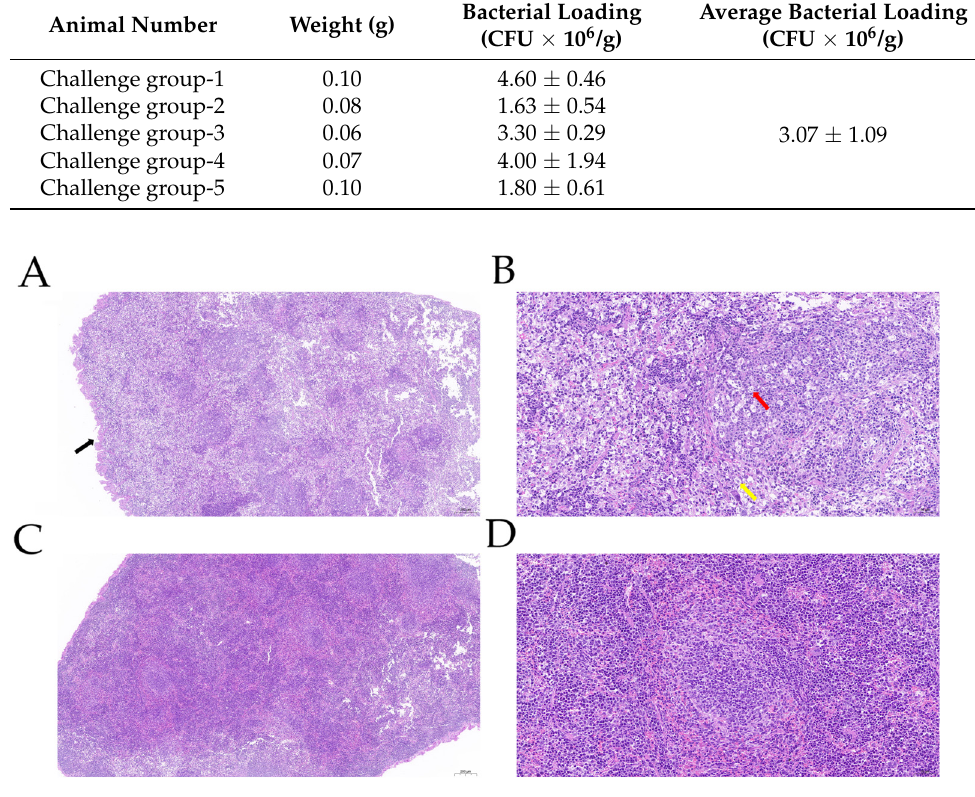
Figure 2. Histopathological analysis of spleen lesions in challenge group ( A , B ) and control group ( C , D ). All the tissues were stained with hematoxylin and eosin. ( A ) Splenic tissue capsule of mice in challenge group was rough (black arrow), 5 × magnification. ( B ) Many lymphocytes in red and white pulp were necrotic and denatured, and nuclei were broken (red arrow). Cell body of macrophages was swollen, and cytoplasm was vacuolar (yellow arrow), 20 × magnification. ( C ) The structure and morphology of spleen tissue in control group were more intact, 5 × magnification. ( D ) Boundary between red and white pulp was distinct, 20 × magnification.